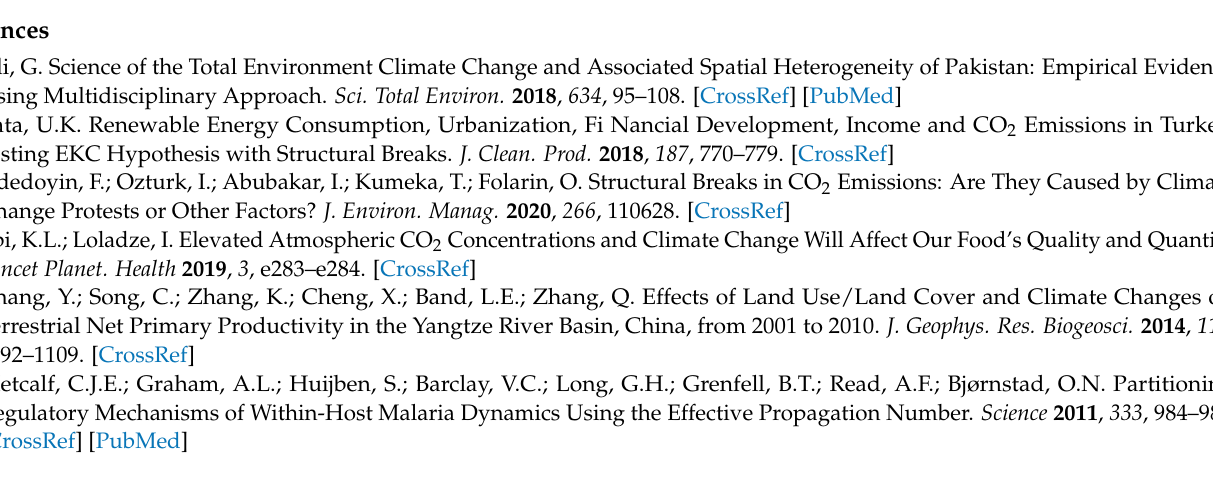
Table S1: counties with reductions in carbon budgets; Table S2: counties with increases in carbon budgets; Codes: codes used in Matlab for realizing the PSO-BP neural network